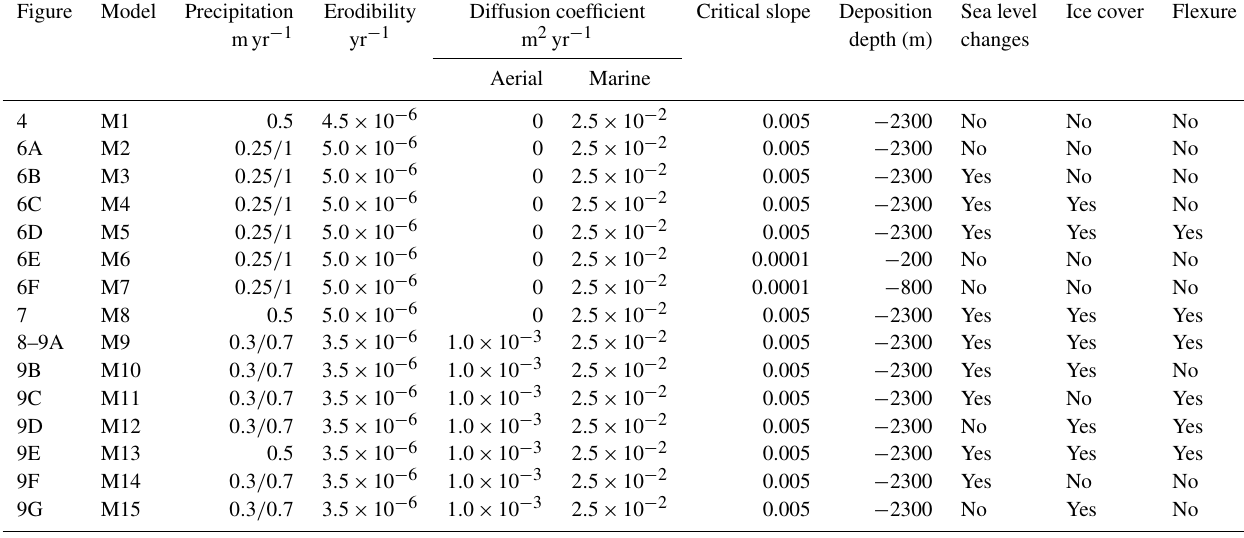
Table 3. Model parameters. Figure Model